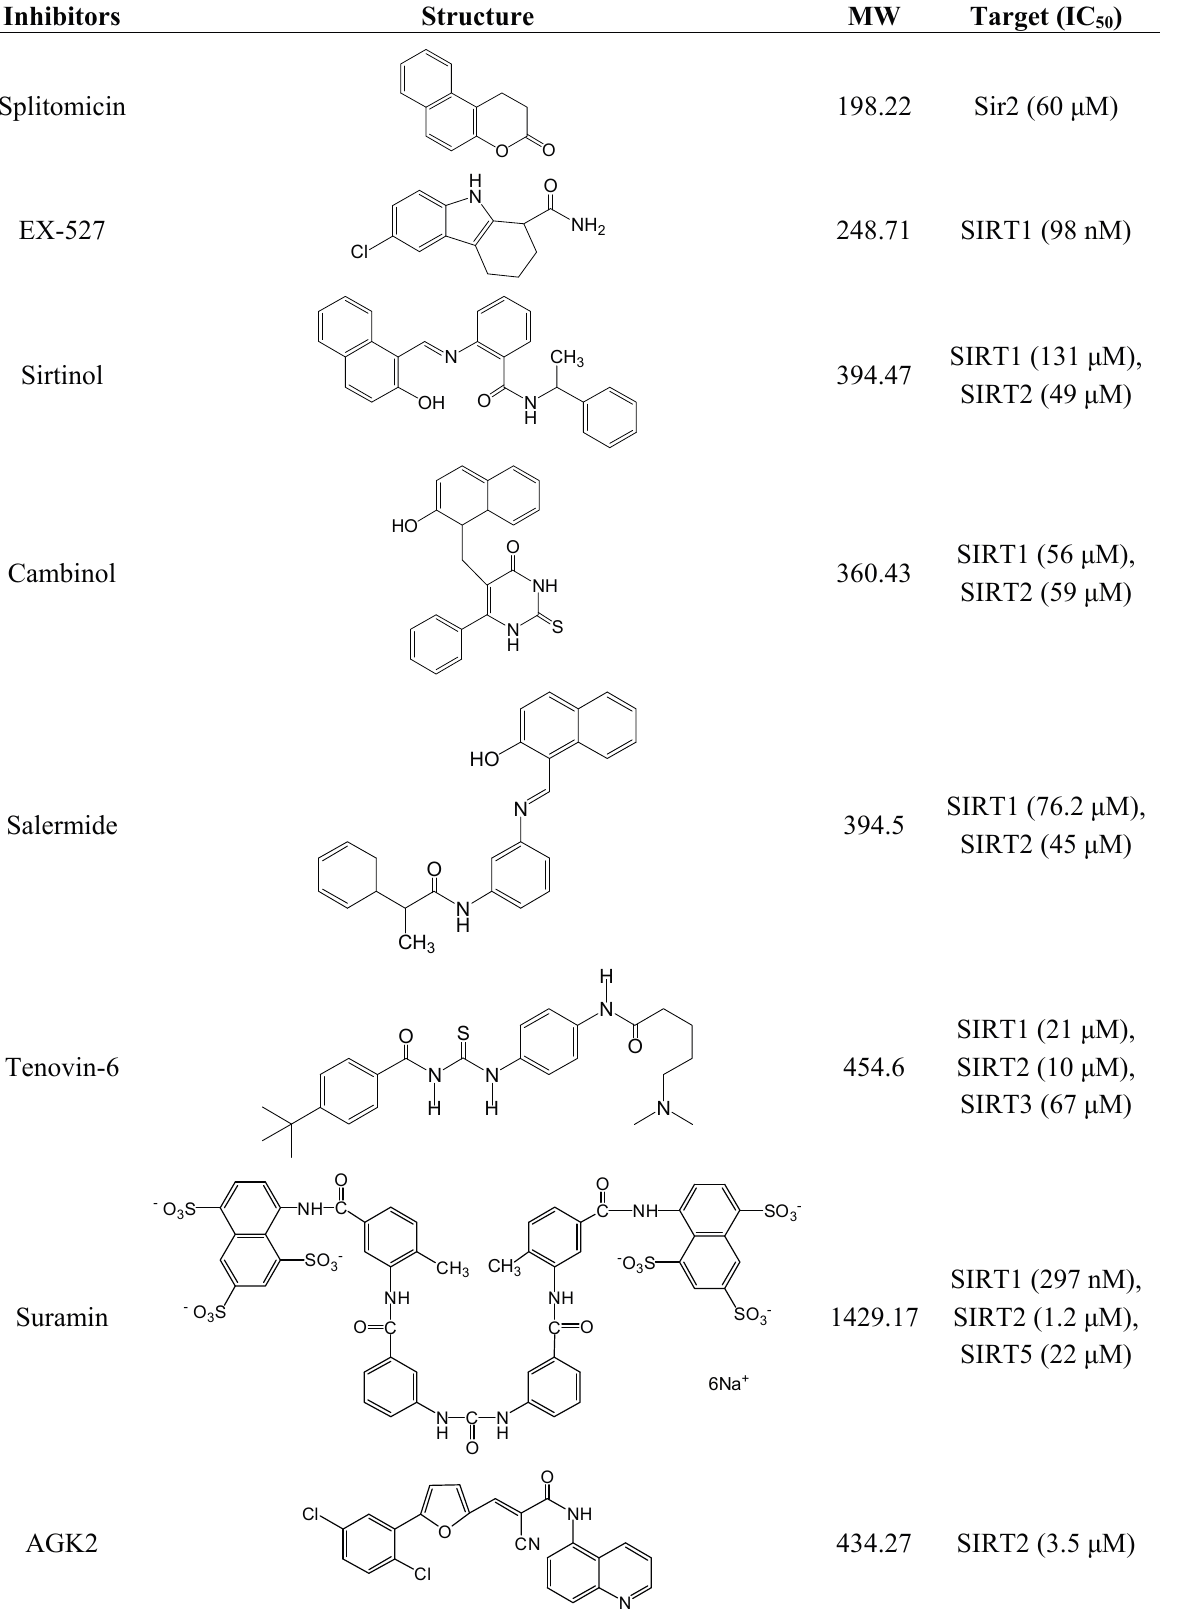
Table 2. Sirtuin